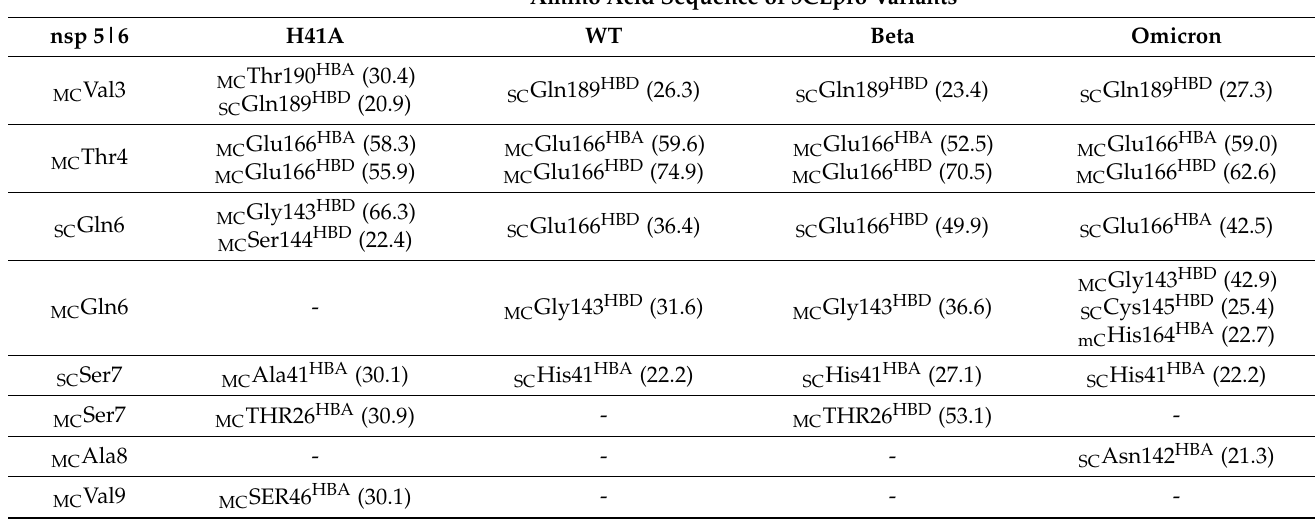
Table 5. Hydrogen bonding occupancies of substrate nsp 5|6 interacting with 3CLpro variants. The hydrogen bonding occupancies considered relevant are at least 20%. Note that MC = main chain; SC = side chain; HBA = hydrogen bonding acceptor; HBD = hydrogen bonding